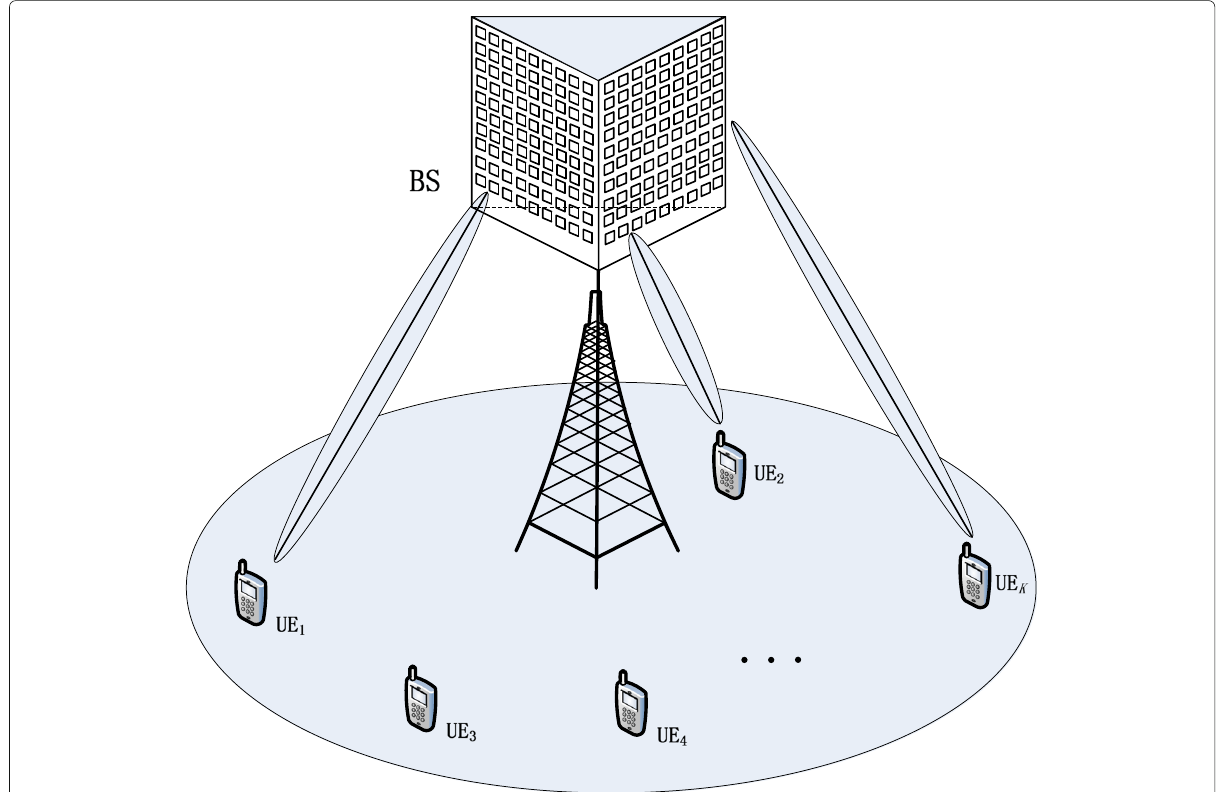
Fig. 1 A schematic diagram of a massive MU-MIMO system equipped with N t transmit antennas serving K